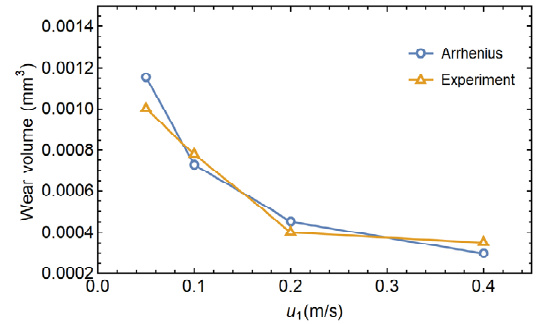
Fig. 11 Wear volume vs. speed.